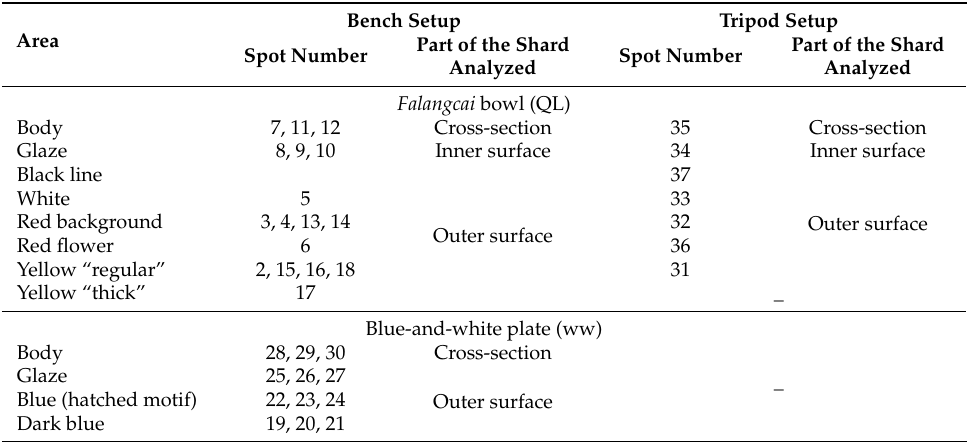
Table 1. Area analyzed and corresponding analysis number for each of the analytical configurations and samples. Details on the measured spots are given as Supplementary Materials (Figure